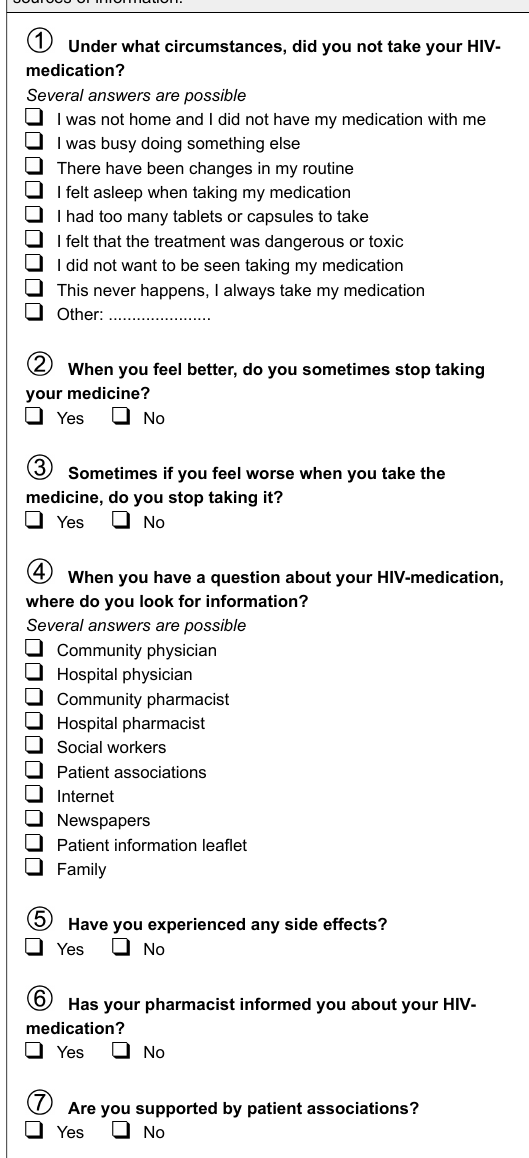
Table 1: Self-reported questionnaire on taking medication and sources of